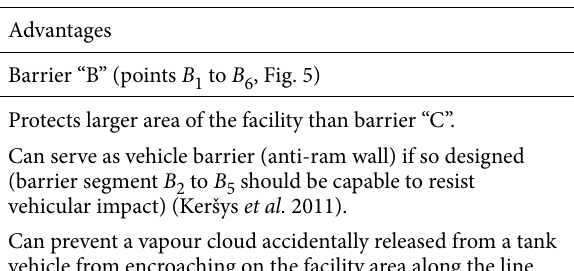
Table 1. List of advantages and disadvantages of the barriers “B” and